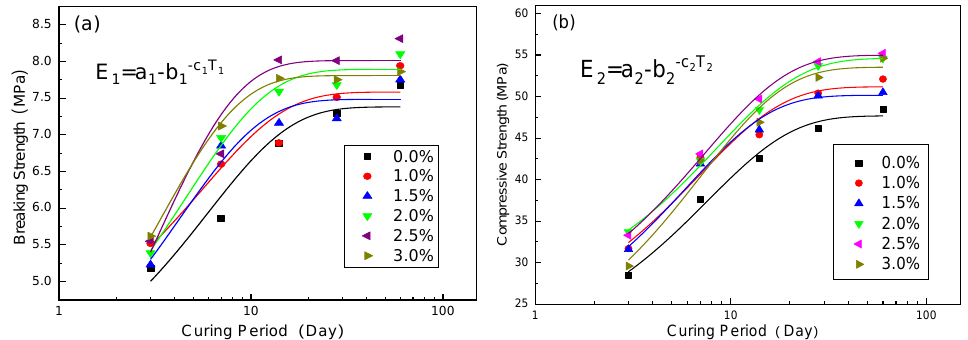
Figure 2. Effects of nano-SiO 2 (NS) on N-MBER (Nanometer Material Becoming Earth into Rock) strength under different NS content and curing period. ( a ) Breaking strength; ( b ) compressive strength. Table 3. Statistical analysis results of strength curve fitting.